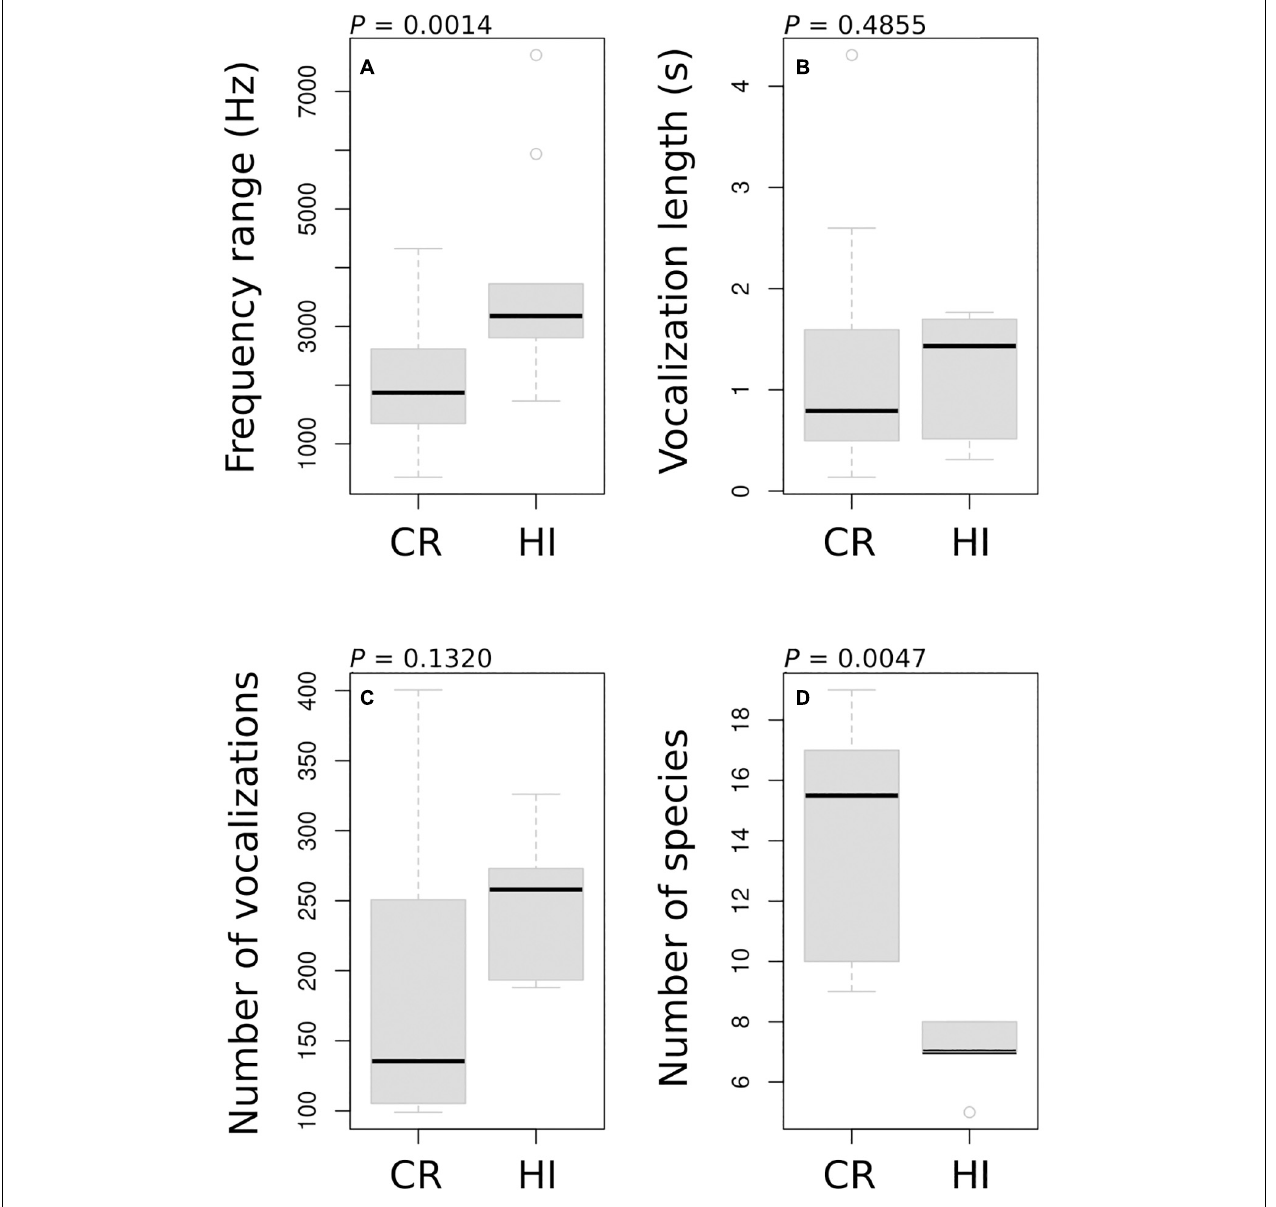
FIGURE 3 | Comparison of species vocalization characteristics (A,B) , the number of vocalizations per 5-min record (C) , and number of species recorded per location (D) between Costa Rica (CR) and Hawai‘i (HI) ( P -value indicates the significance of Wilcoxon’s rank sum